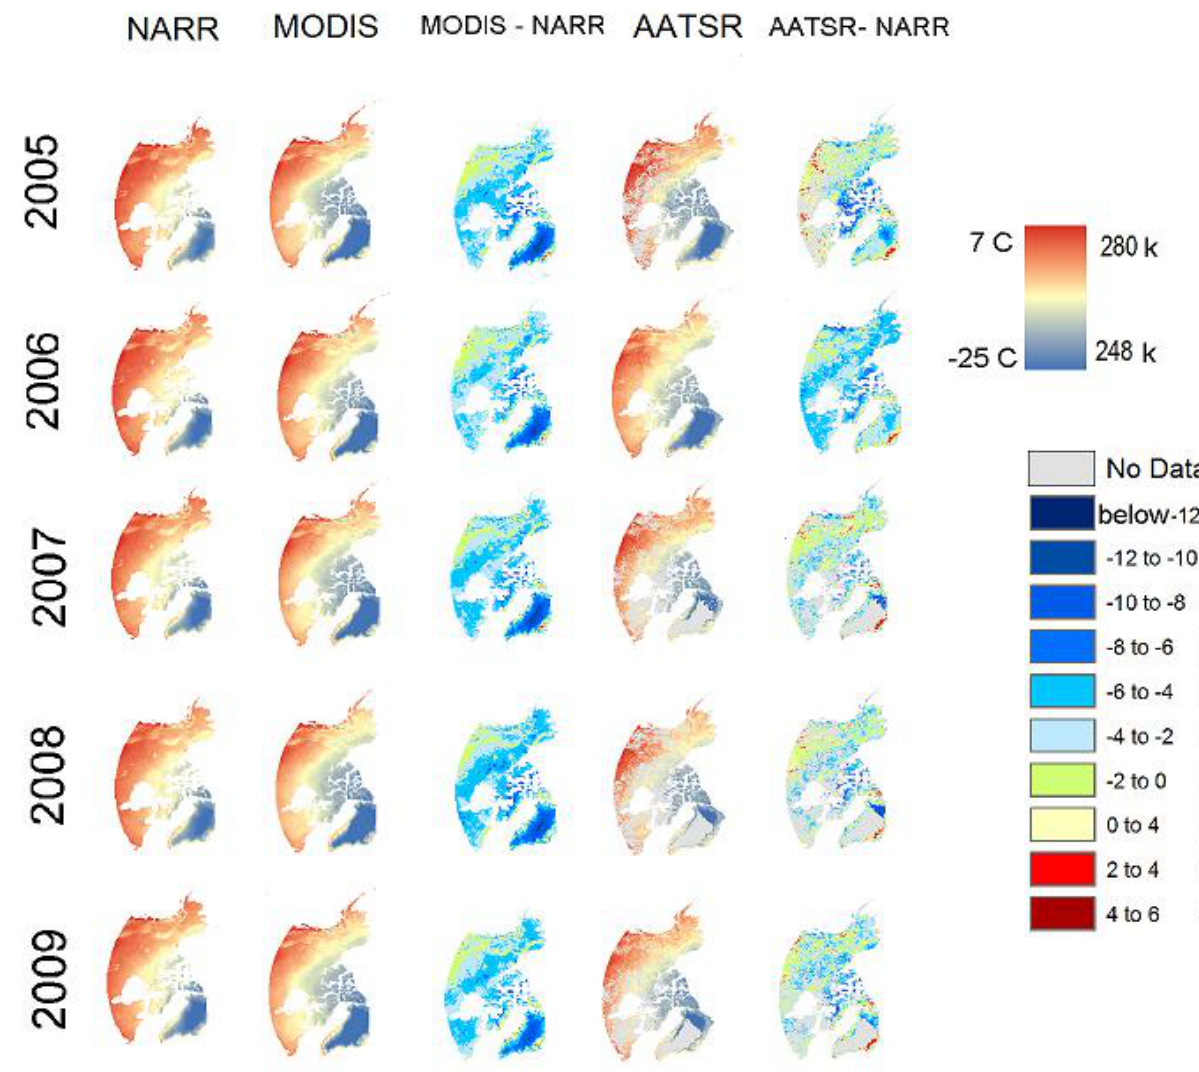
Figure 11. Mean annual surface temperature (MAST) calculated from monthly 0-m height surface temperature of NARR and MODIS/AATSR LST and difference between NAAR and MODIS/AATSR calculated MAST (2005–2009). For AATSR, any pixel found to have more than two missing months during one year was discarded from the calculation of